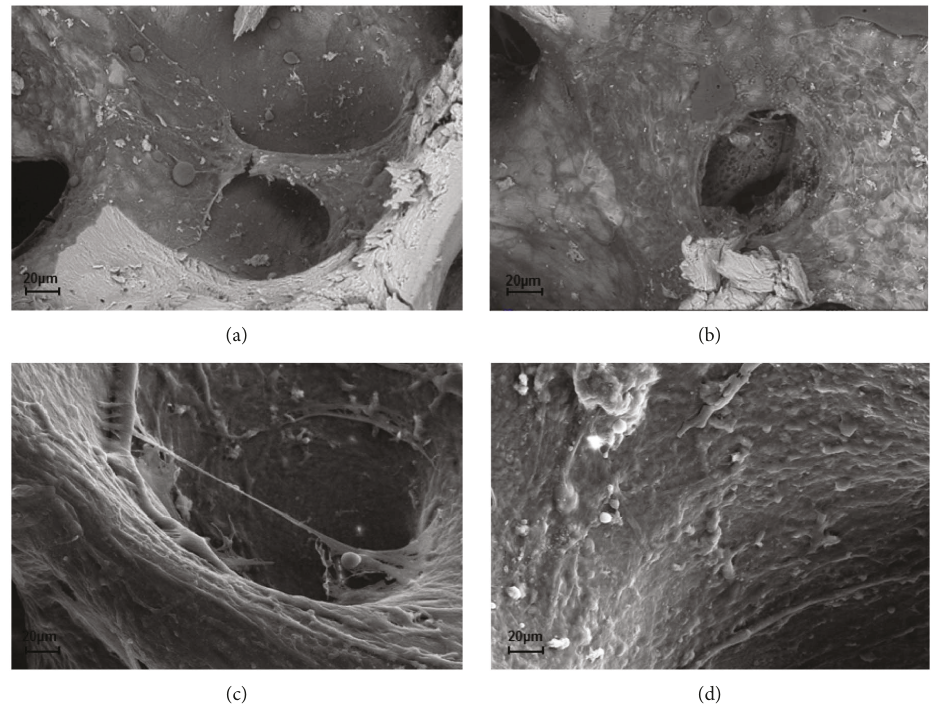
Figure 5: Analysis of new bone formation by SEM. Representative SEM images depicting SB after 30 days of culture with ASCs (a, c) and SVFs (b, d), respectively, at low (a, b) and high (c, d) magni fi